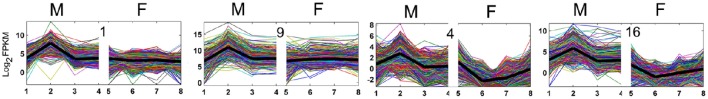
Clustering of significantly differential expressed orthologous genesusing k-means clustering method according to the gene expression profiles in V. montana (M) and V. fordii (F) infected with the pathogen F. oxysporum. The differential expression modes were classified into twenty clusters in V. montana, and the corresponding orthologous genes in V. fordii were analyzed for their expression modes (Supplemental Figure S4).